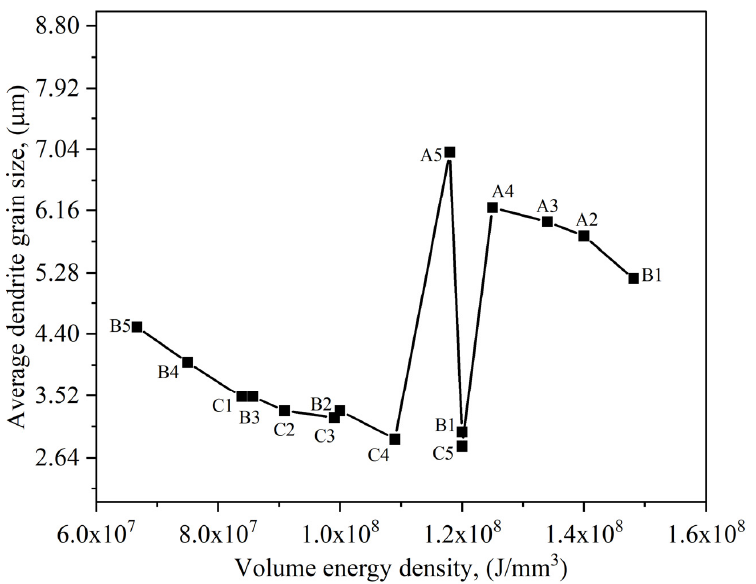
Figure 14. A correlation between volume energy density and average dendrite grain size.